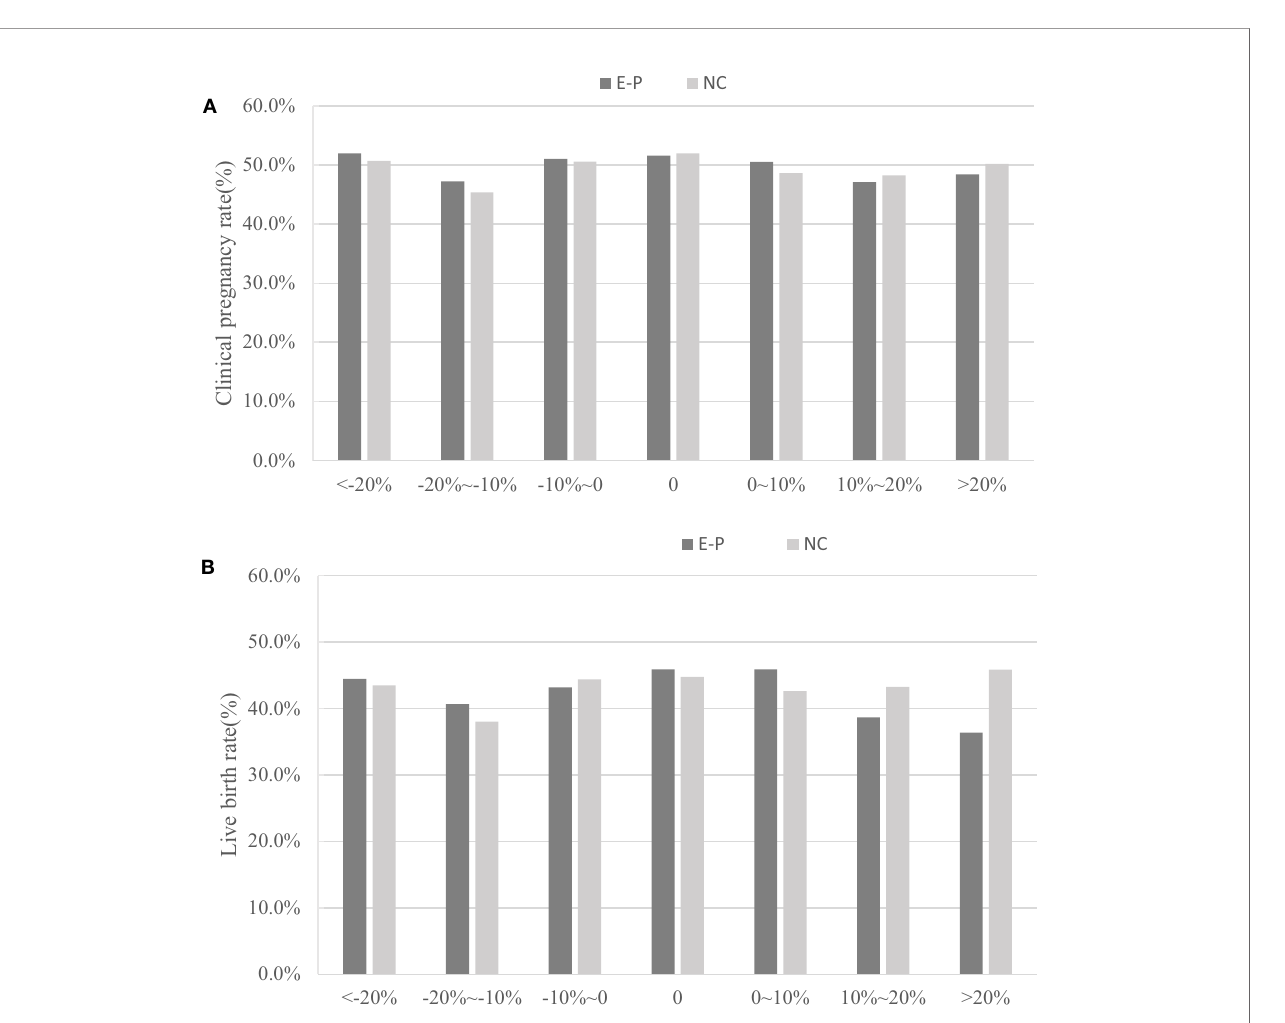
FIGURE 2 | Relationship between the endometrium change ratio and pregnancy outcomes (clinical pregnancy rate and live birth rate). E-P, estrogen-progesterone cycle; NC, natural cycle. (A) represents clinical pregnancy rate; (B) represents the live birth